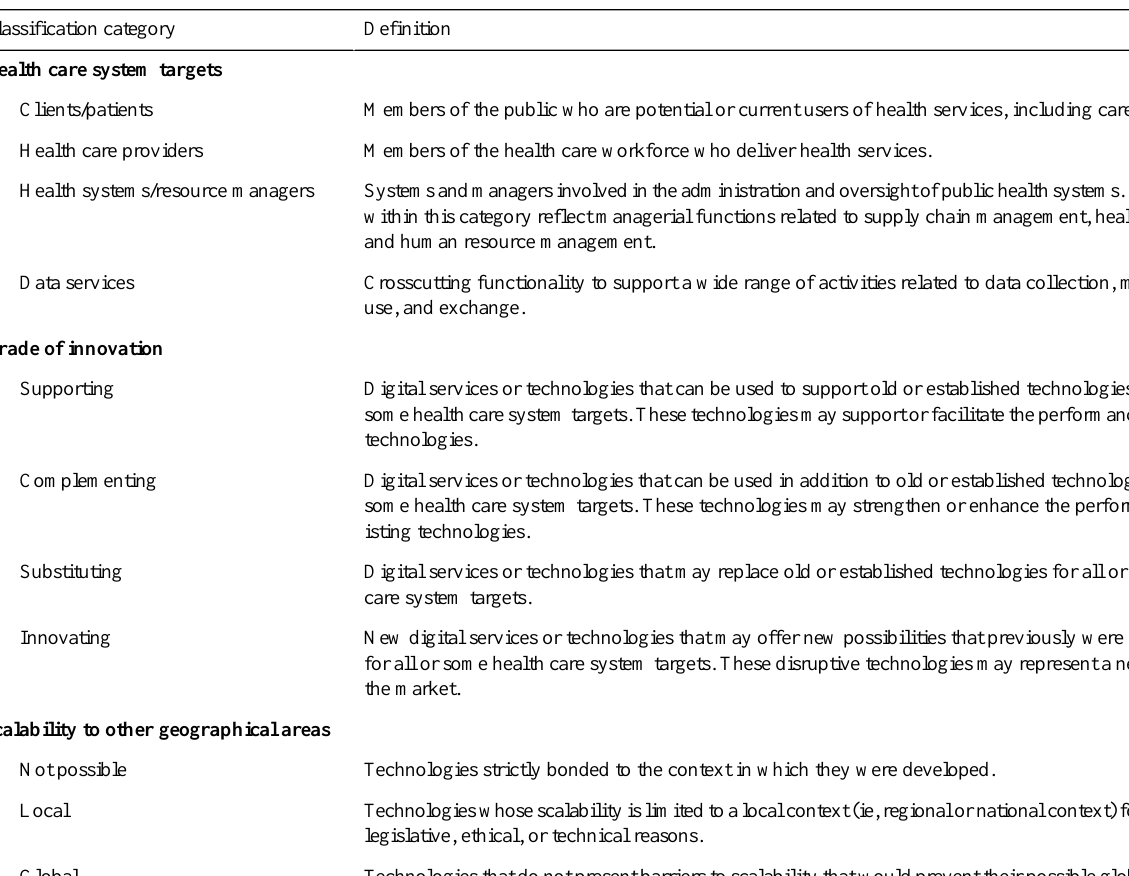
Table 2. Classification of digital technologies and health